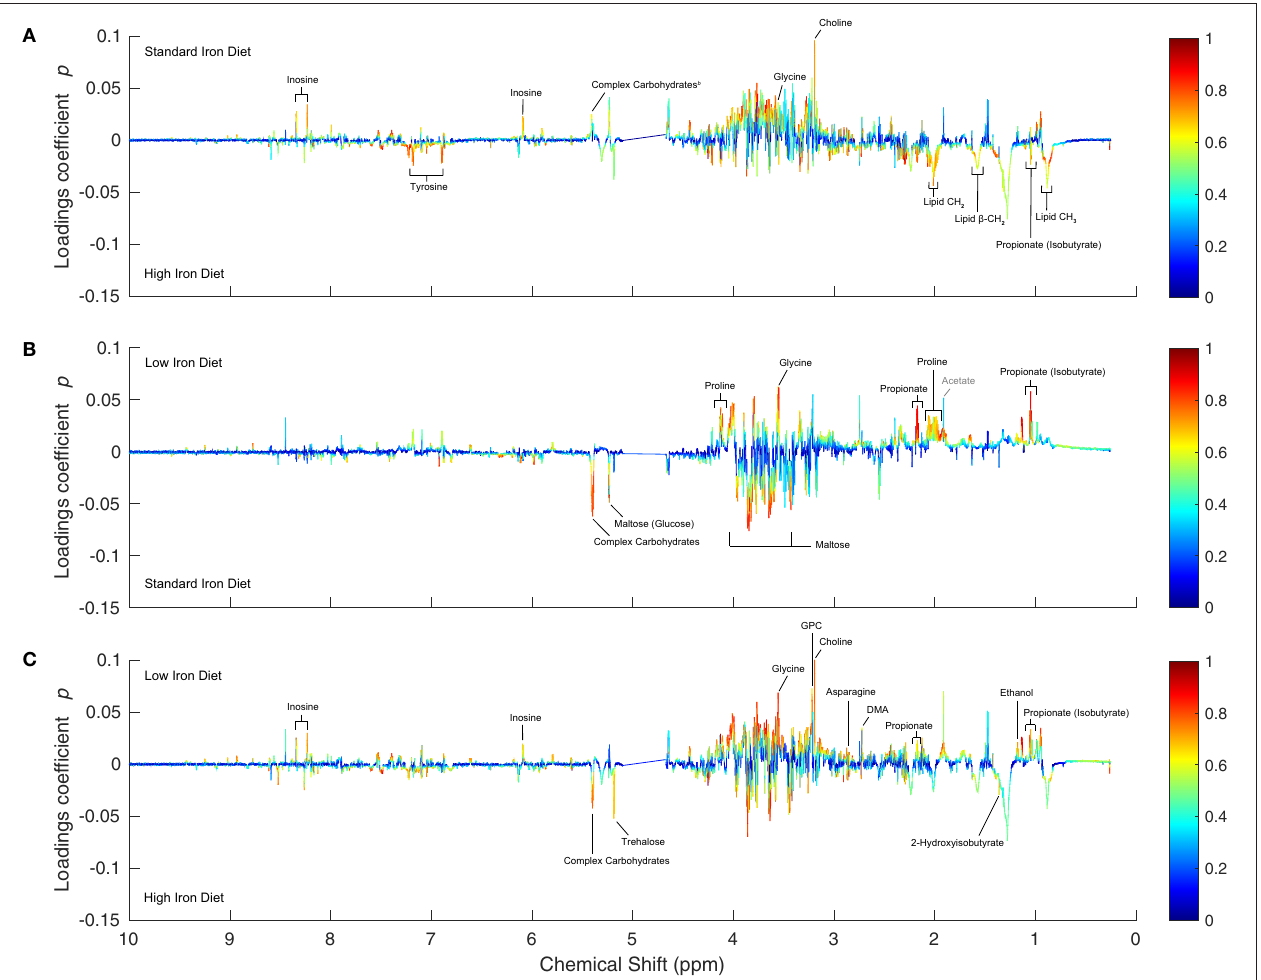
FIGURE 4 | OPLS 1D S-Plots of the pairwise diet comparisons for Wolbachia -infected samples. (A–C) The 1D S-plots are analogous to Figure 2 , but show the diet comparisons for Wolbachia -infected samples. The significantly altered metabolites ( | p | ≥ 0.015 & | p ( corr )| ≥ 0.6) are annotated in black in each panel: (A) High- v. standard-iron diet (model M11 ), (B) Standard- v. low-iron diet (model M12 ), and (C) High- v. low-iron diet (model M13 ). Gray annotations: metabolites referred to in the